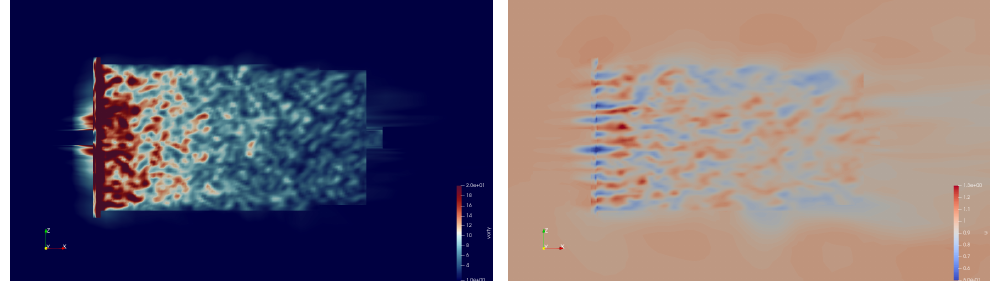
Figure 7. Effect of turbulence generation on the flow field downstream of the generation region. ( Left ): vorticity magnitude. ( Right ): u 1 velocity component. Representative time step t 1 > T conv